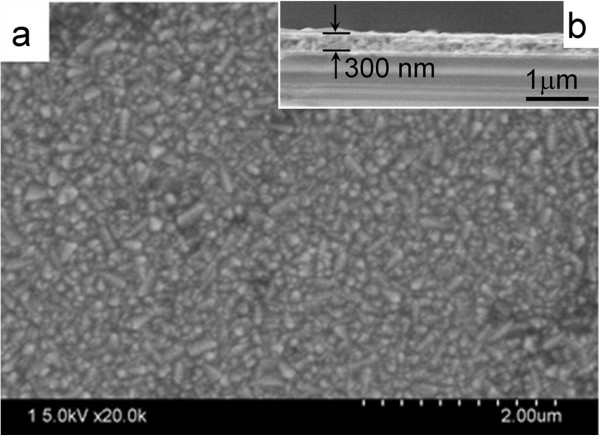
Surface (a) and cross-sectional (b) SEM images of dense TiO2 layer.